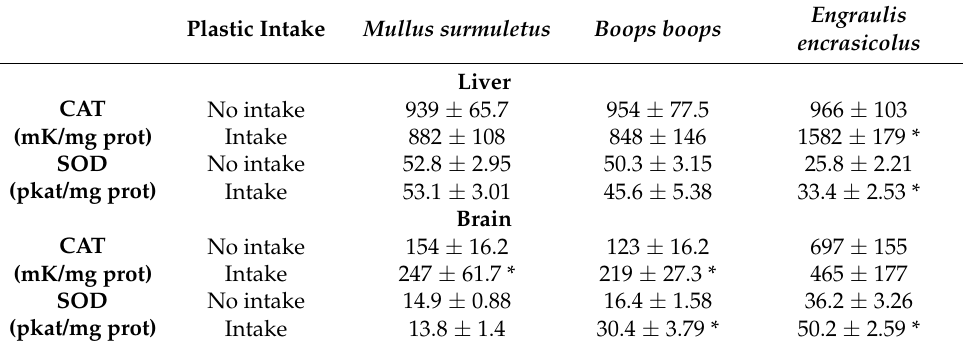
Table 3. Antioxidant enzymes damage in the liver and in the brain in three fish